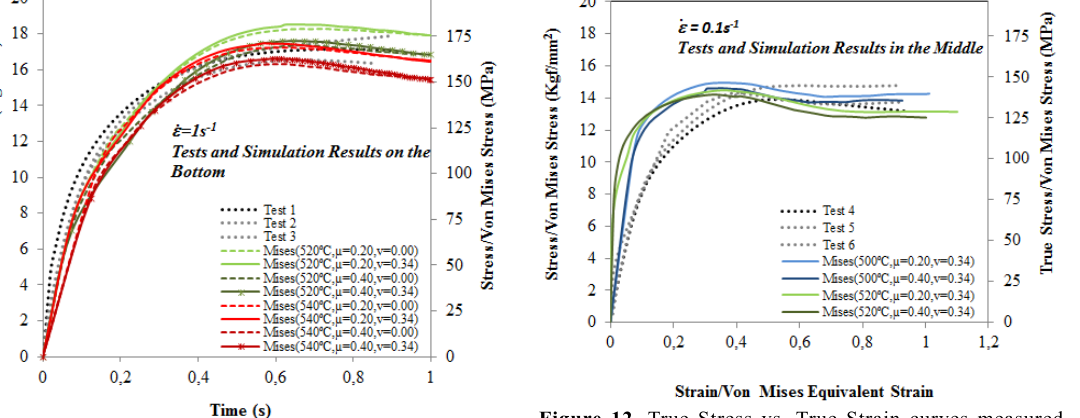
Figure 10. True stress vs. True Strain curves from experiments (dotted lines), and Von Mises Stress vs. Von Mises Equivalent Strain curves on the bottom of the sample from simulations (solid and dash lines), all of them for tests at 540 °C and strain rate of 1s -1 . Figure 11 are the results of Load vs. Displacement with a strain rate of 1s -1 .